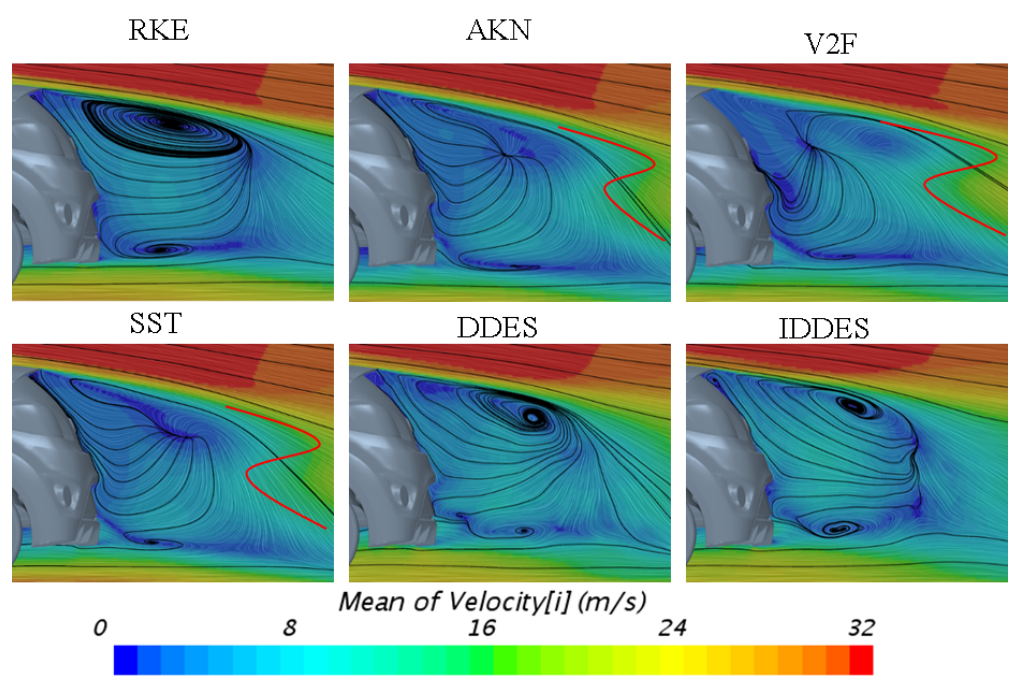
Figure 13. Vector scene with constrained streamlines in the wake region (on the central plane of the vehicle) for the baseline case from all models